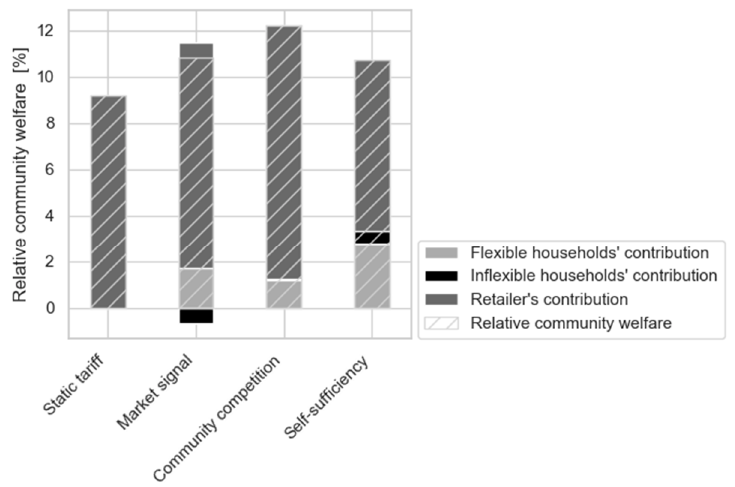
Figure 10. Community welfare in comparison to the BAU case.